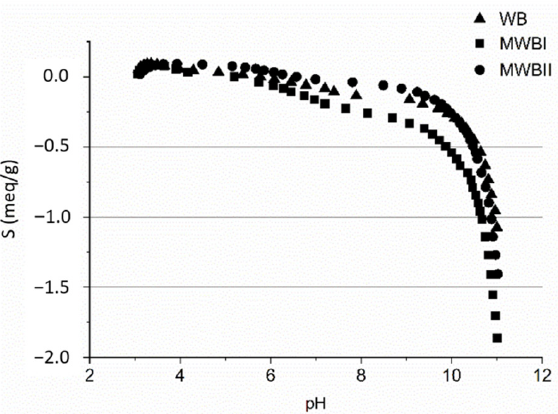
Figure 3. Potentiometric titration curve of untreated WB, magnetically modified MWBI, and MWBII at a background electrolyte NaCl.